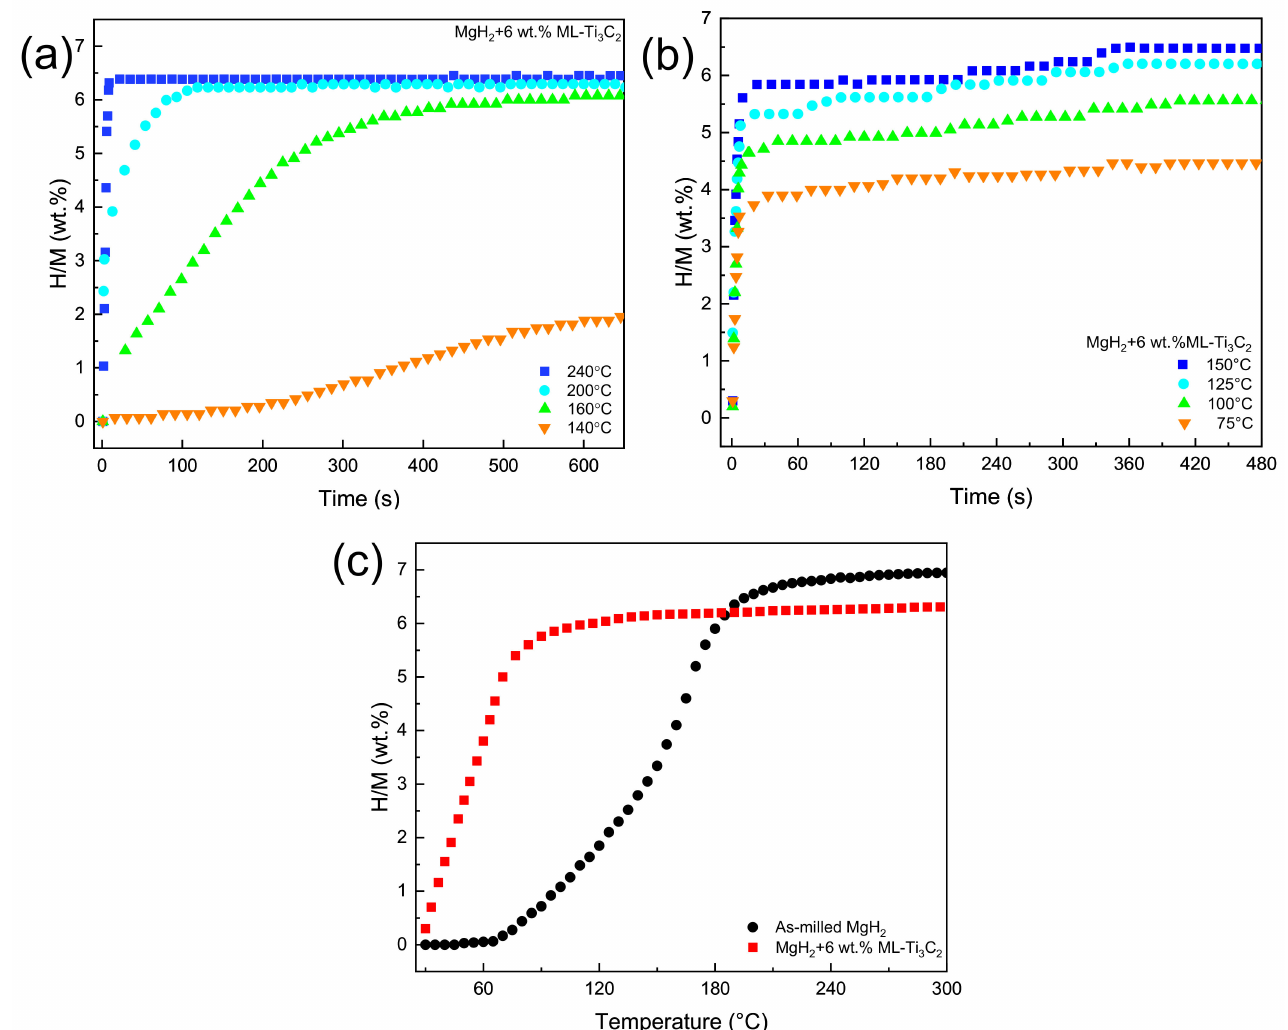
Figure 3. De/hydrogenation performance curves of MgH 2 -6 wt.% ML-Ti 3 C 2 and as-milled MgH 2 . ( a ) Isothermal de- hydrogenation curves at different temperatures. ( b ) Isothermal rehydrogenation curves at different temperatures. ( c ) Non-isothermal absorption curves of two